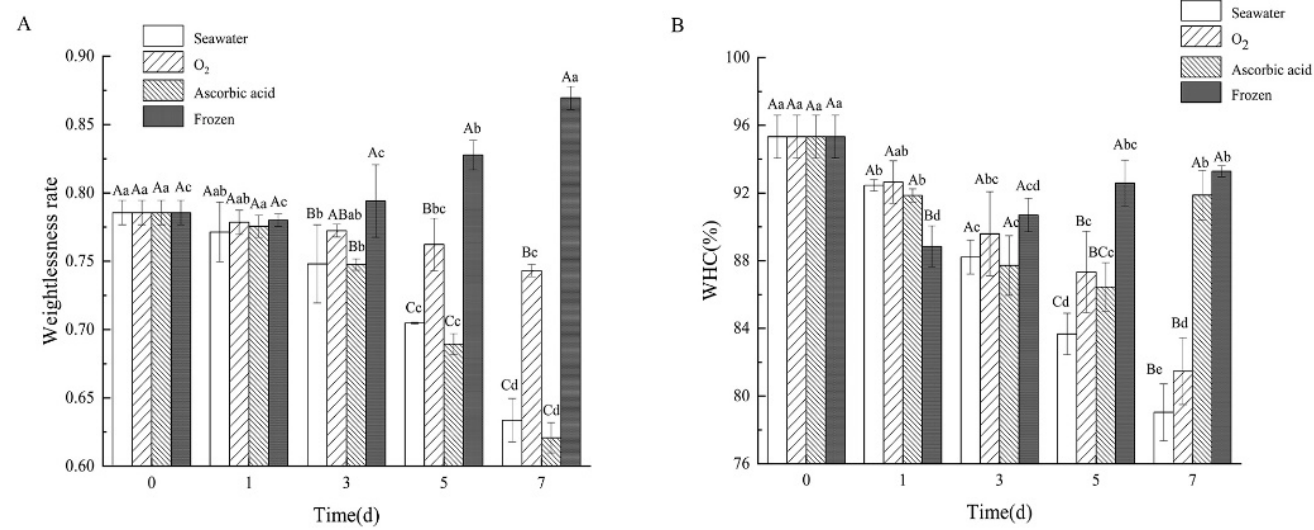
Figure 5. Changes of ( A ) weightlessness rate and ( B ) WHC of boiled SJBW in different treatment groups during storage. Dates are presented as mean ± SD ( n = 3). Different capital letters indicate significant differences in the average between groups. Different lowercase letters indicate significant differences in the average value within each group ( p < 0.05).